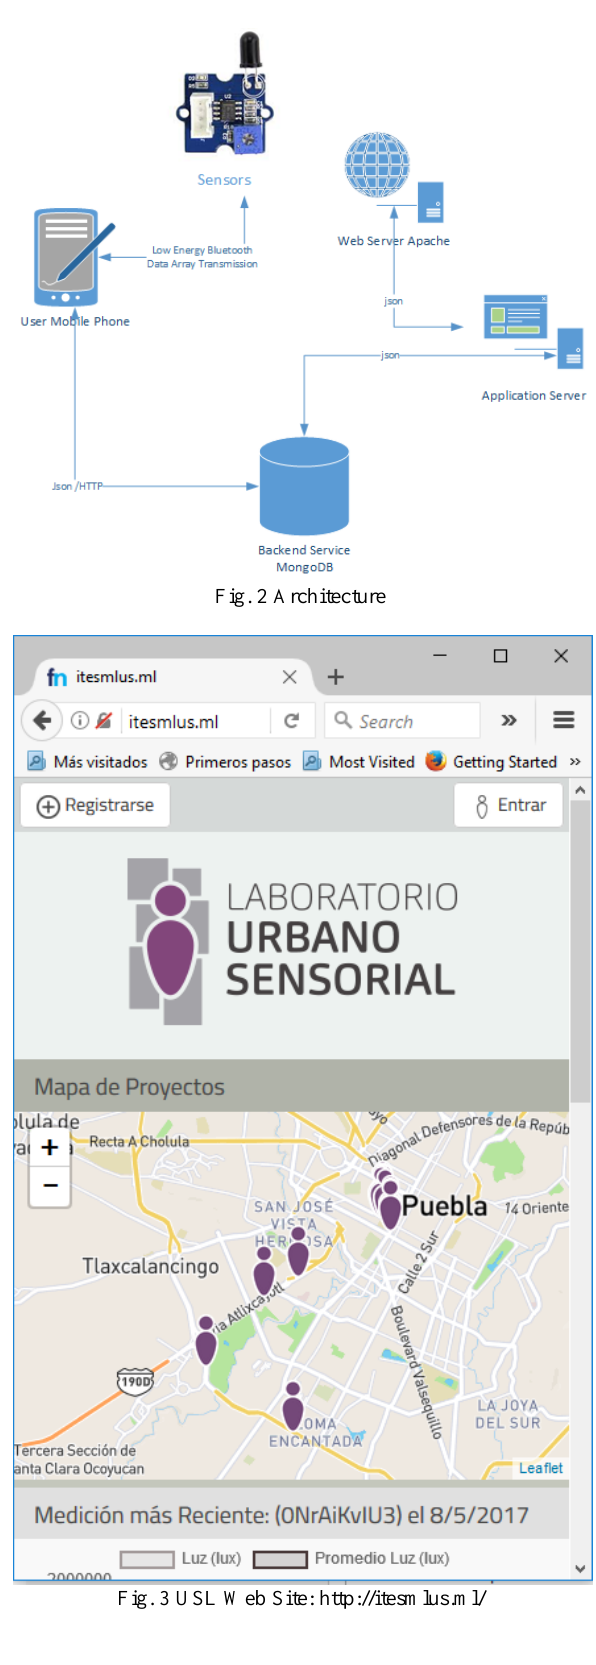
Fig. 3 USL Web Site: